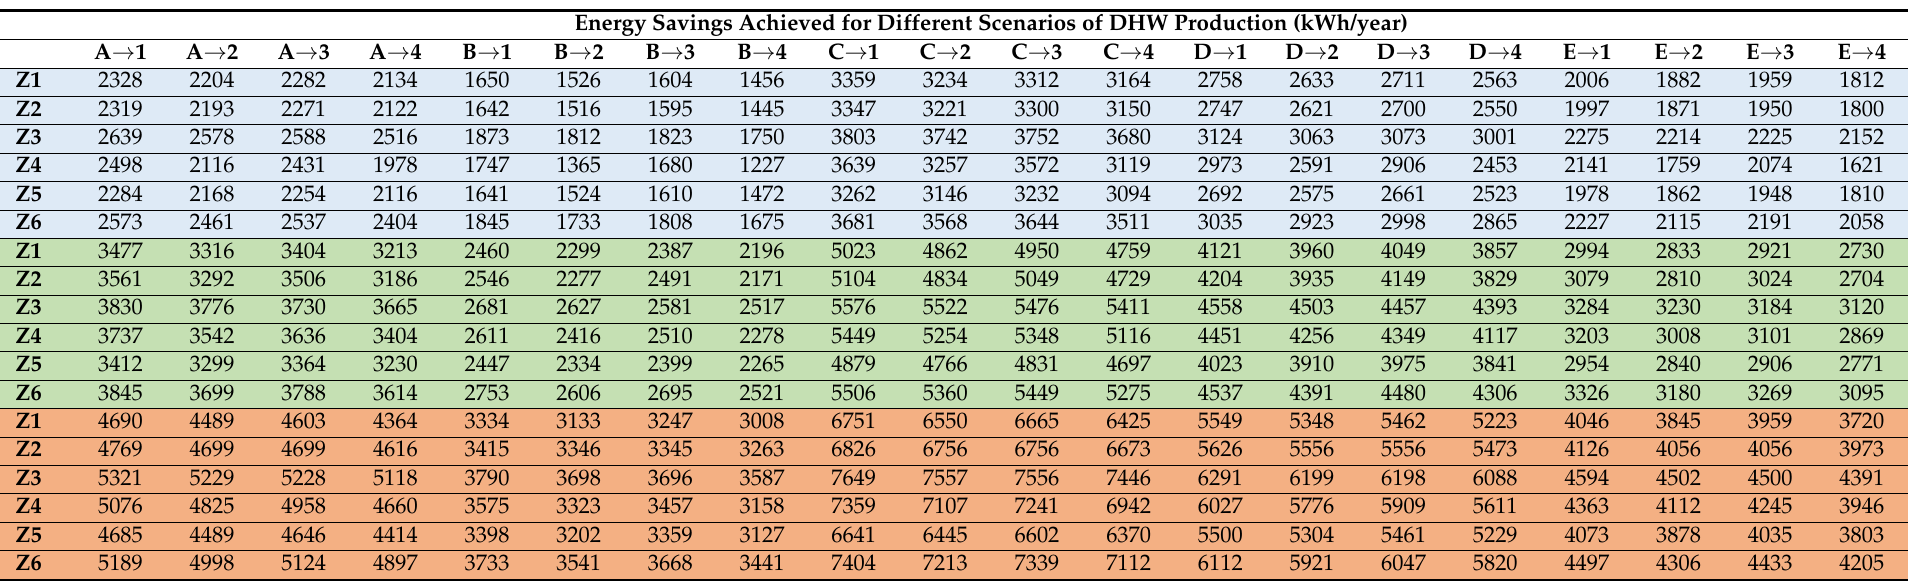
Table 12. Energy savings achieved for the different scenarios of SWH